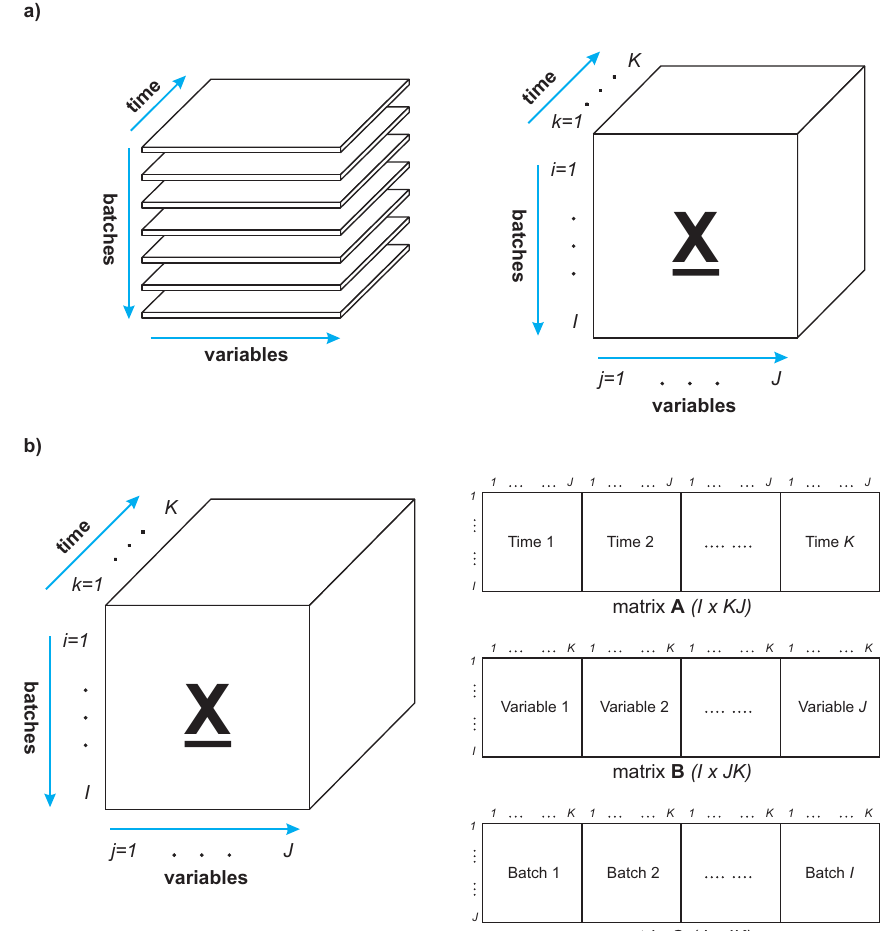
Figure 1. Graphical representation of methods to unfold a three-dimensional data matrix: ( a ) Three-dimensional data matrix of a batch process. ( b ) Unfolding methods of a three-dimensional data